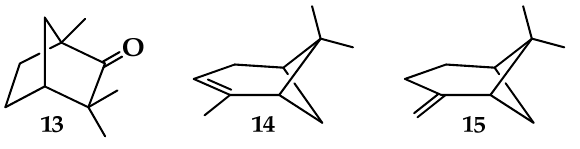
Figure 8. The dependence of the D(O) on the AIP for hydrocarbons 2 – 12 .